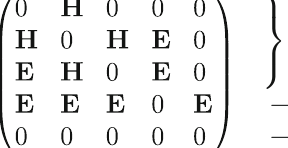
Fig. 5 Five-point function with dual contributions coupled by hyperboloid singularities